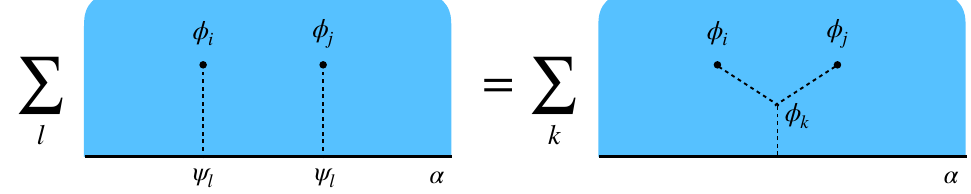
Figure 1. The bootstrap constraint (2.12) arising from equating the boundary and bulk OPE of the bulk two-point function h φ i ( z 1 ) φ j ( z 2 ) i α